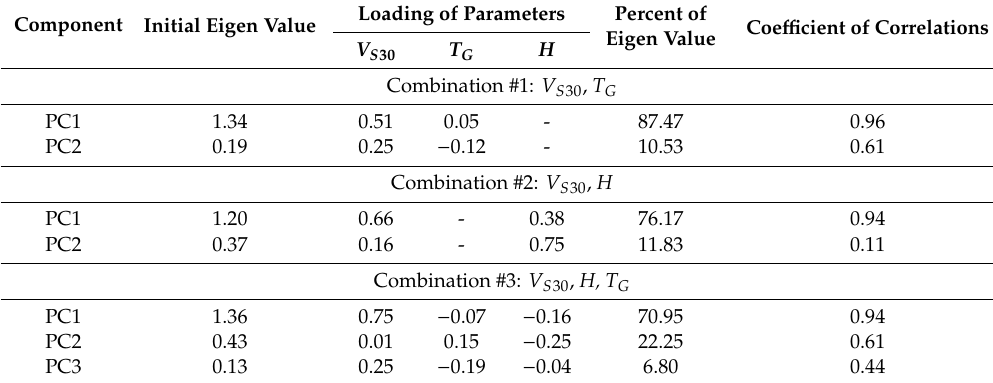
Table 3. Results of principal component analysis combinations for combined multivariate site response